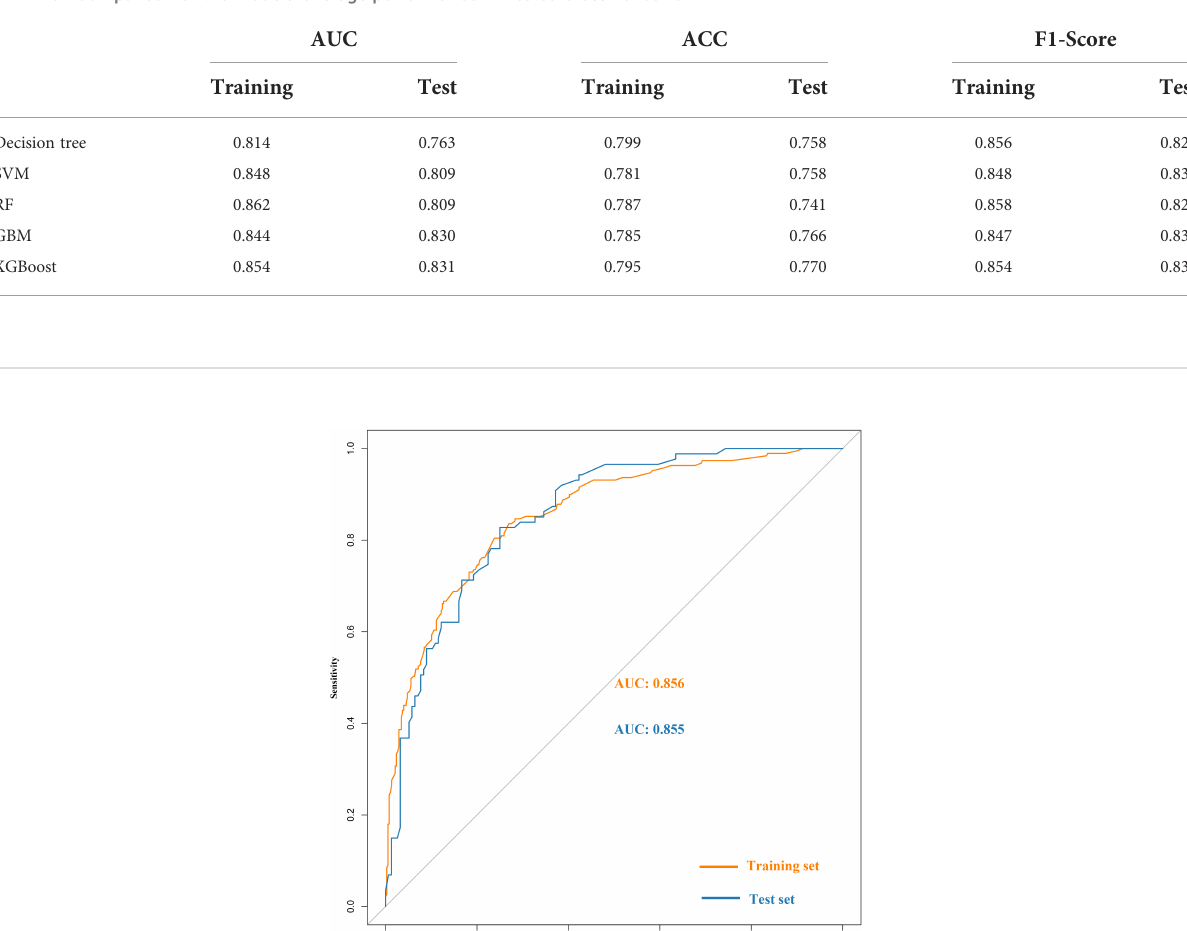
TABLE 3 Comparison of the models ’ average performance in nested cross-validation.